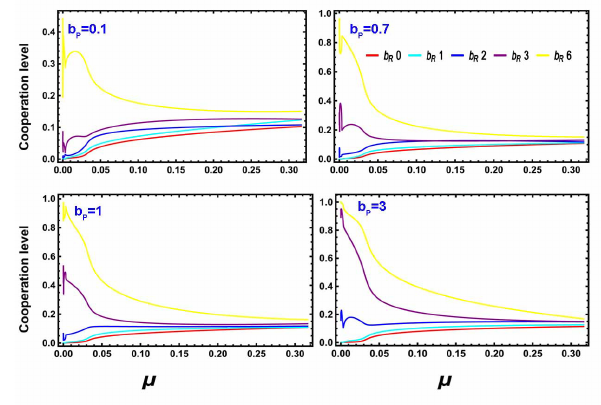
Figure 3. Frequencies of CCC for increasing muta- tion rate, µ . It represents the trends of different b values for the stated value of b parameters as in Figure 1.